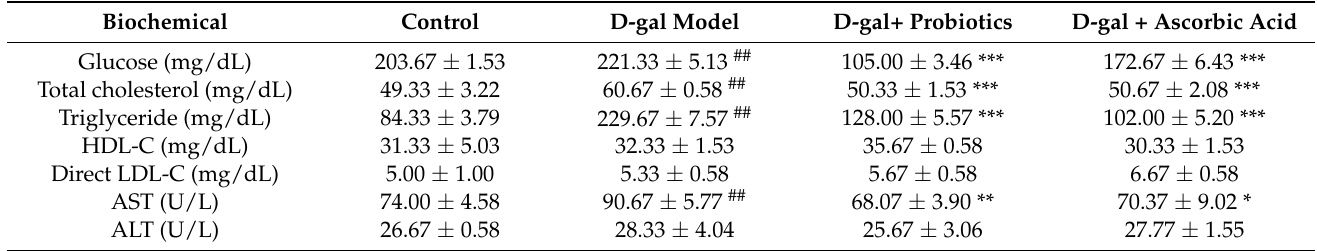
Table 2. Effect of B. animalis MSMC83 on biochemicals in